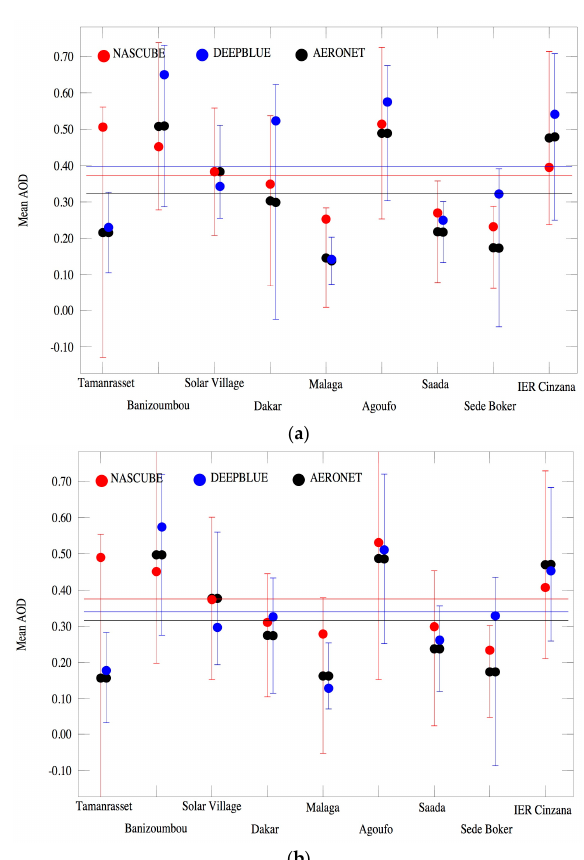
Figure 11. The AOD mean values and standard deviations with respect to AERONET for the NASCube (red) and Deep Blue (blue) at nine different locations from 2007–2012: ( a ) taking into account all measurements acquired by each instrument with a week integration time; and ( b ) the three instruments are synchronized to the Deep Blue acquisition time ± 10 min.